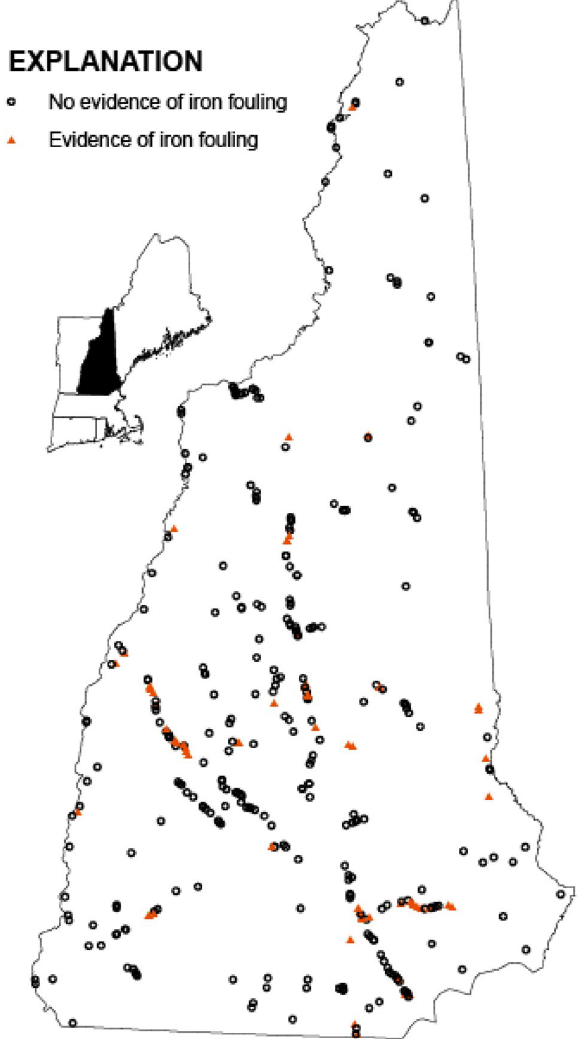
Fig. 1 Presence or absence of iron fouling at 374 rock-fill sites